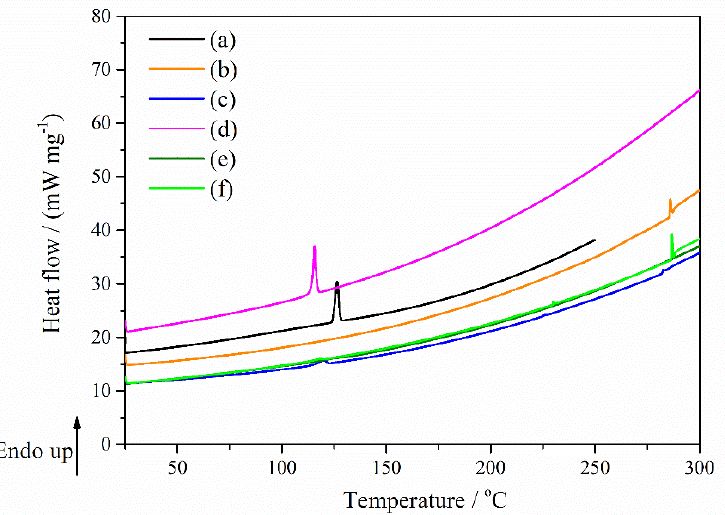
Figure 12. DSC curves of ( a ) Nim; ( b ) Me- β -CD; ( c ) Nim–Me- β -CD physical mixture; ( d ) Nim–Me- β -CD coprecipitation method; ( e ) Nim–Me- β -CD lyophilization method; ( f ) Nim–Me- β -CD kneading method.